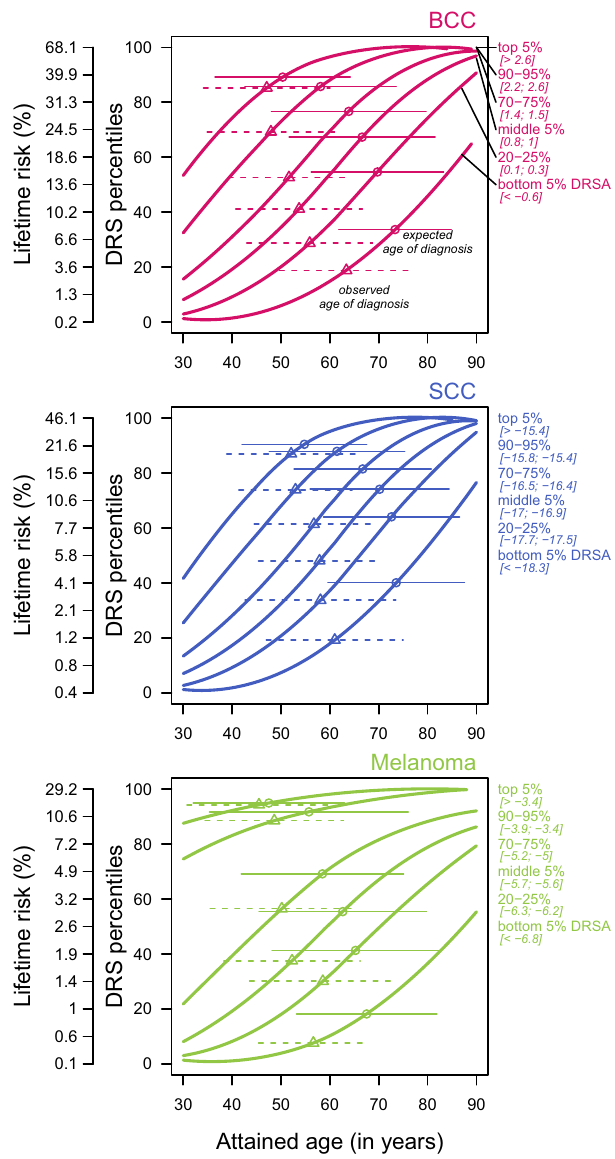
Fig. 5 Lifetime skin cancer risk strati fi ed by DRSA percentiles. The expected ages of diagnosis (mean and SD) were computed using yearly incidence rates derived from the lifetime risk curves, and assuming CDC survival estimated rates, in White American, for the year 2017 (see “ Methods ” for details). The observed ages of diagnosis (mean and SD) were calculated in the validation set (88,924 participants, see Supplementary Table